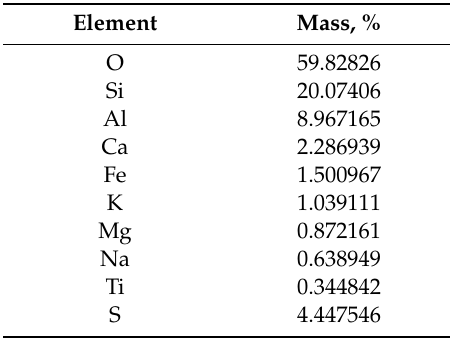
Table 1. Elemental composition of FA / H 2 SO